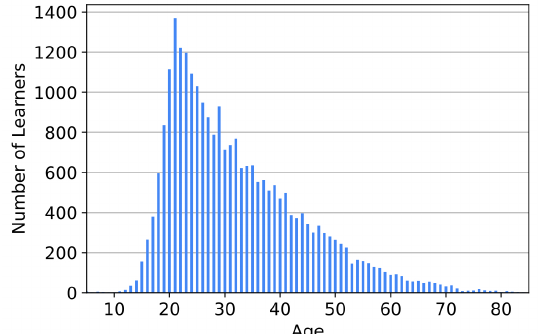
Figure 13. Age demographics based on voluntarily provided information. We have learners who are still in high school to learners who are retired and learning TinyML to understand its impact on our global society.